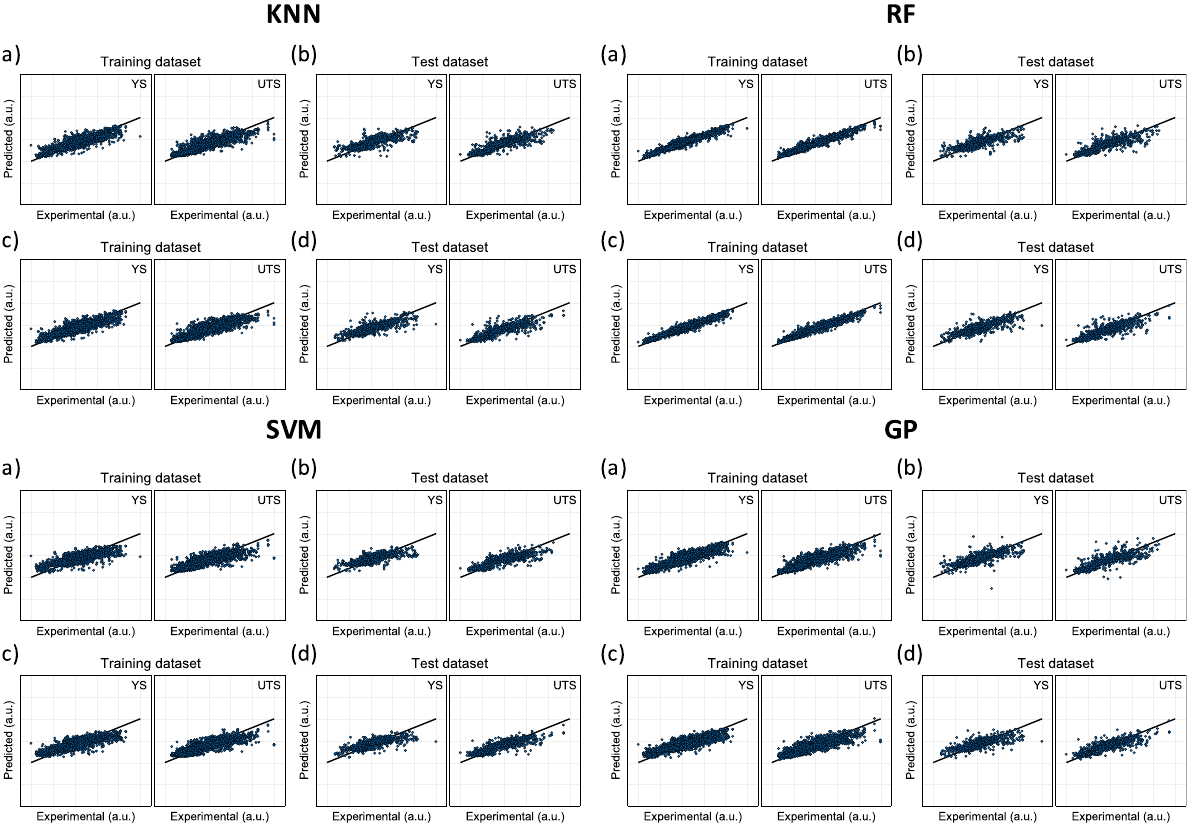
Figure 5. The ML results for KNN, RF, SVM, and GPR. The predicted output versus the real output for ( a ) the training dataset, ( b ) the holdout test dataset for a 16-input-feature ML, ( c ) the training dataset, and ( d ) the holdout test dataset for an 8-input-feature